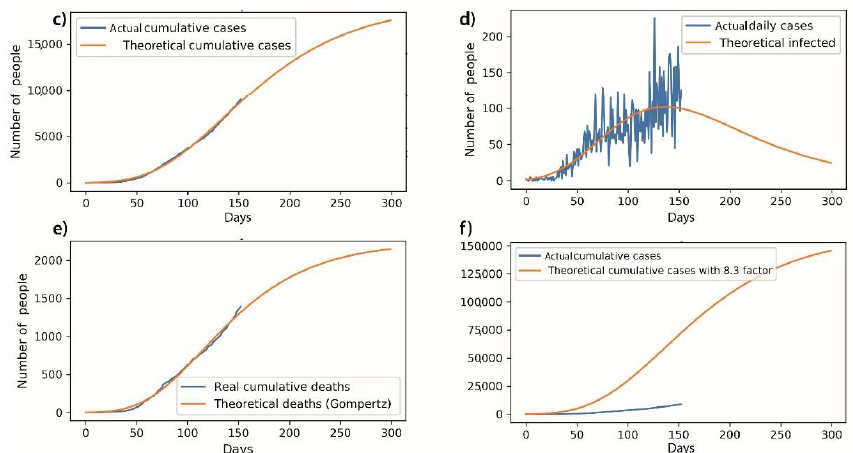
Figure 3. The adjustment of the SEIR, SEIRS+ package, and Gumpertz model is observed with the parameters described above. The resulting curves are shown below, where curve ( a ) shows the initial adjustment of SEIR curve, ( b ) shows the adjustment of SEIRS+ Network Model curve, ( c ) shows the infection curve with daily official cases, ( d ) shows the adjustment of official data with the theoretical curve development, ( e ) shows the cumulative death curve, and ( f ) shows the proportion of theoretical deaths according to the model and with the expansion factor (8.3) defined by the Federal Ministry of